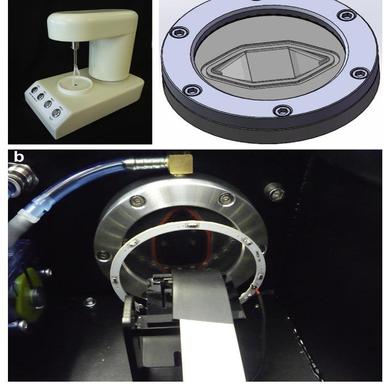
Low-shear mixer designed to mimic domestic reconstitution (a) and flow cell design (b,c): external diameter 100 mm, measurement zone path length 0.4 mm.